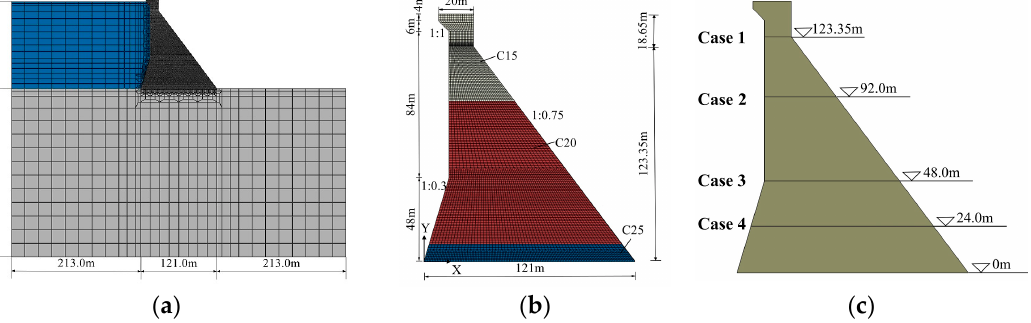
Figure 9. FE model of Guandi RCC dam-reservoir-foundation system. ( a ) 2D model of the system; ( b ) detailed plot of the dam; ( c ) four cases with different locations of RCC layers.